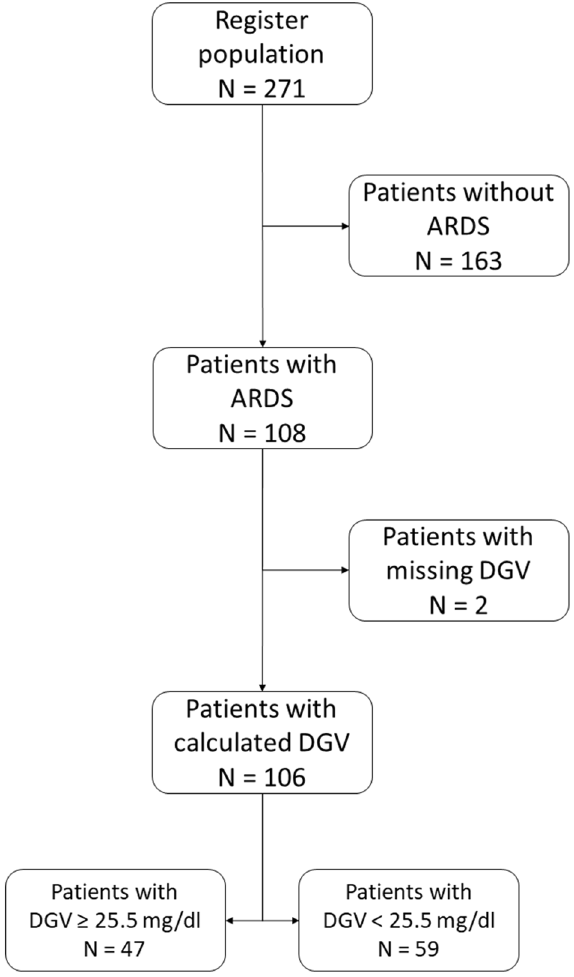
Figure 1. Flowchart of patient enrolment. The register population represents all patients included in the COVAS cohort. A total of 106 out of 271 patients were enrolled in this subgroup analysis. ARDS acute respiratory distress syndrome; DGV daily glycaemic